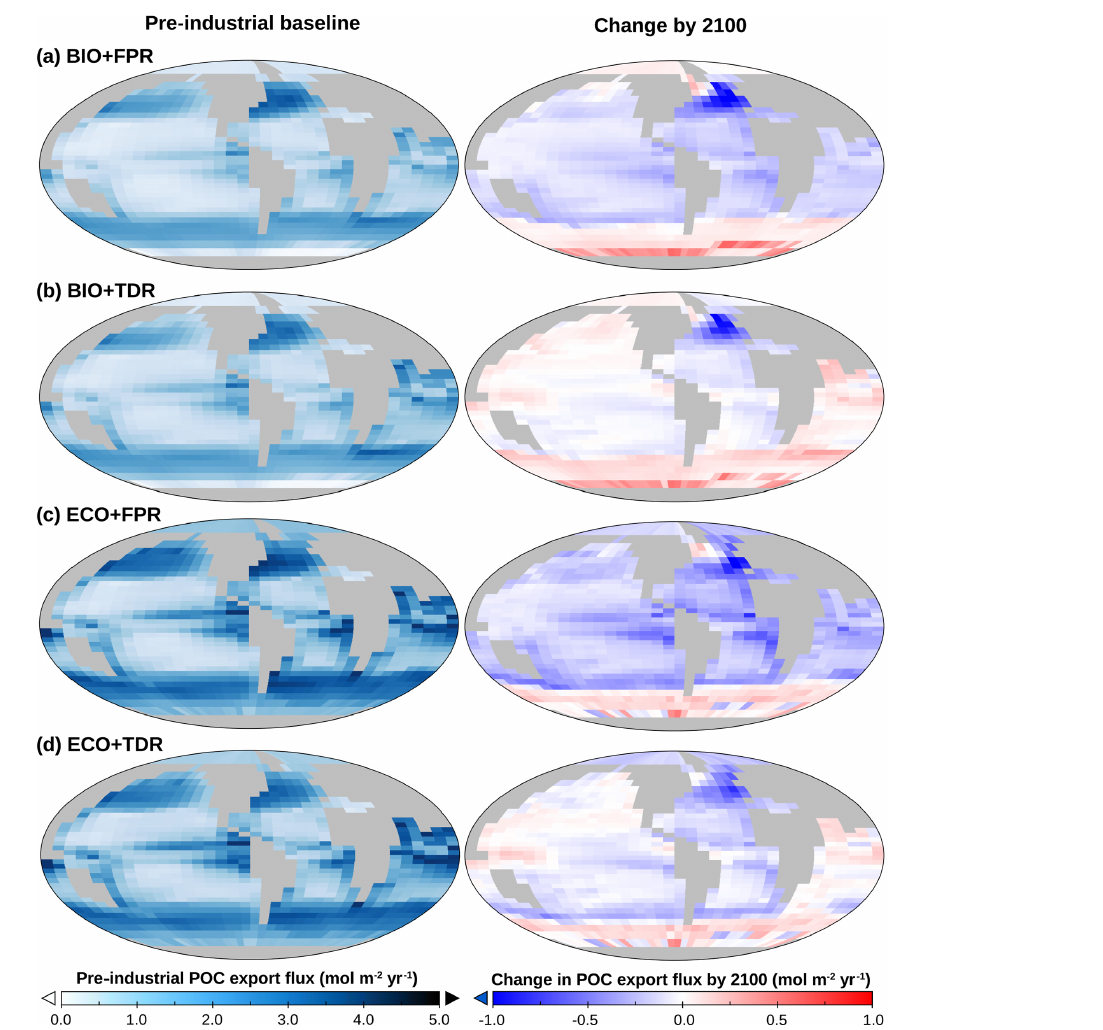
Figure 3. (a) cGEnIE and ecoGEnIE POC export maps for default calibrations of BIO+FPR (a) , BIO+TDR (b) , ECO+FPR (c) , and ECO+TDR (d) , showing baseline export patterns (left) and the change in POC export by 2100 relative to the 1765 pre-industrial baseline as a result of RCP4.5 (right). Plot created with Panoply, available from NASA Goddard Space Flight